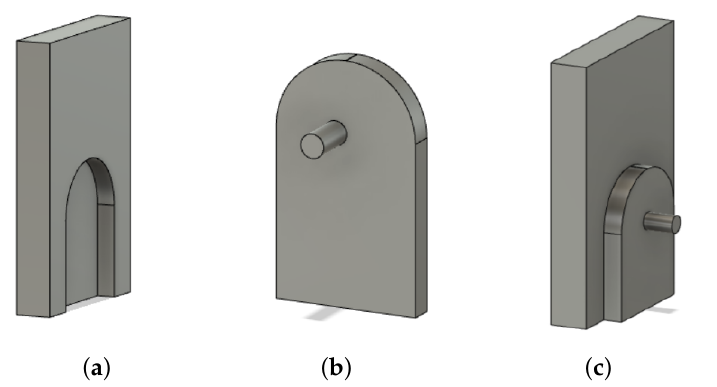
Figure 3. Charging System Entities. ( a ) Socket. ( b ) Charging Kiosk with cable and connector gun. ( c ) Charging kiosk connected with